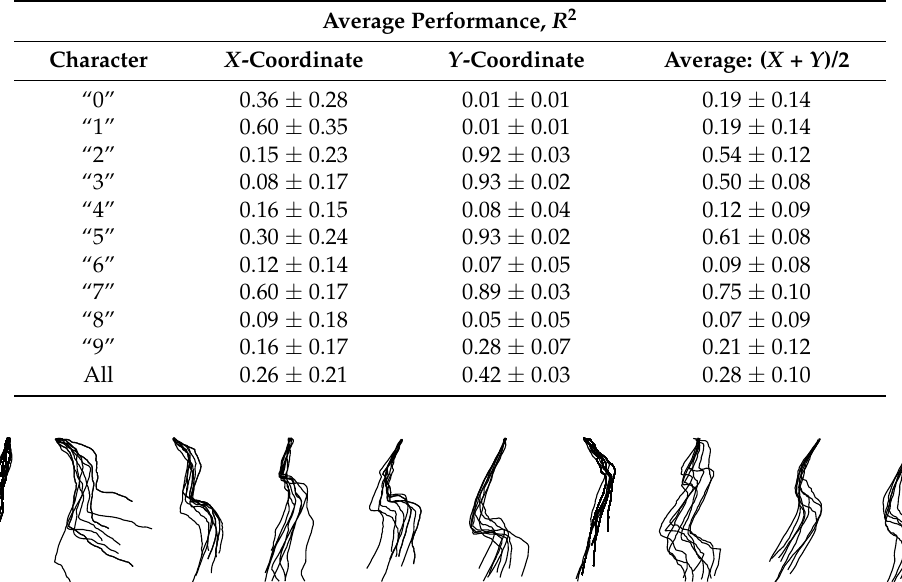
Figure 10. The randomly selected reconstructed numeric character of within-group reconstruction by the KF.